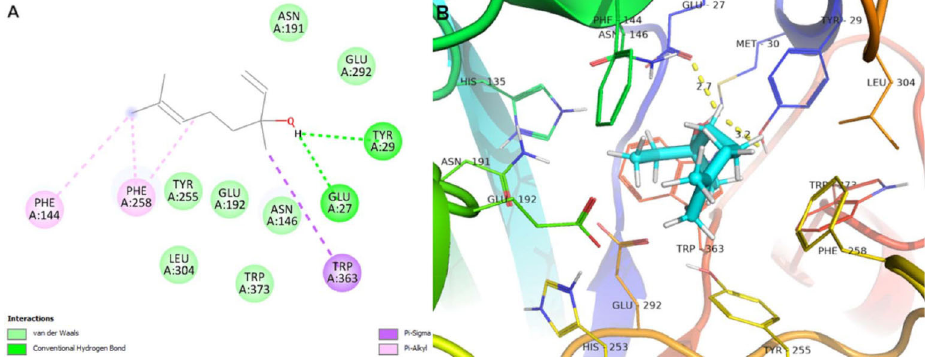
Figure 4. Molecular docking analysis. A , Two-dimensional interactions. B , Three-dimensional representation of linalool interactions in the 1,3- b -glucan synthase active site. Dotted yellow: hydrogen-bond interactions.